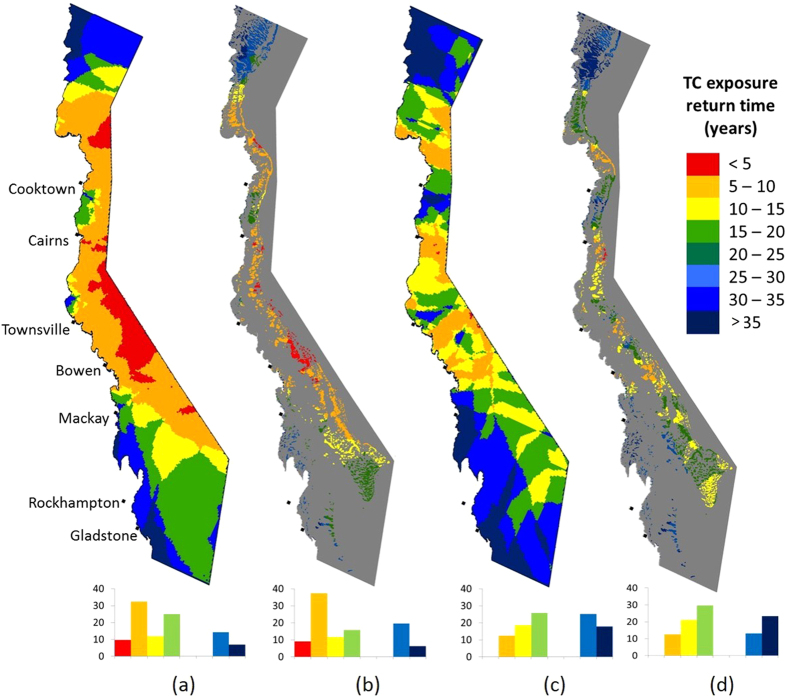
Comparison of spatial patterns of return times for severe TC damage in the GBR, 1985–2015, based on 4MW (a,b) and AHF. ((c,d) - images on the right are reefs only). Return times indicate the predicted number of years between each time a pixel is located in a predicted damage zone. Pixels with return times greater than 35 years were not located in a TC damage zone from 1985–2015. Methods for 4MW and AHF are in Table 1 and the Supplementary Material. ArcGIS 10.2 software (https://www.arcgis.com/features/) was used to create the maps.